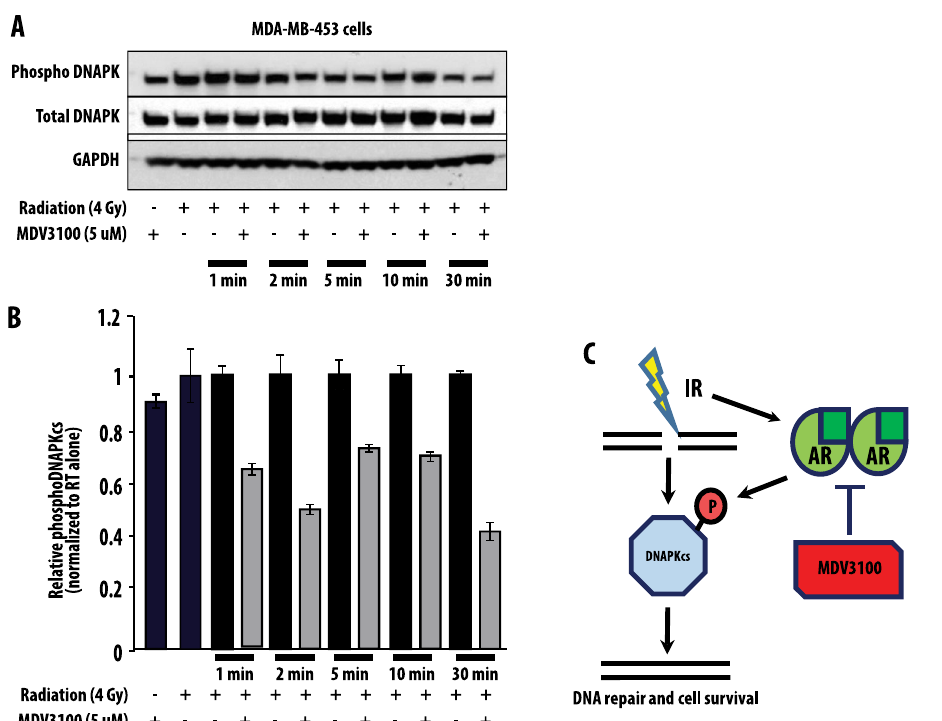
Fig. 6 Total DNAPKcs levels are unchanged by RT treatment, but treatment with MDV3100 decreased phosphorylated DNAPKcs levels after ionizing radiation. Total DNAPKcs and phosphoDNAPKcs levels were measured ± RT and ± MDV3100 treatment at 1, 2, 5, 10, and 30 min ( a ). Quanti fi cation of phosphoDNAPKcs changes ± MDV3100 radiation treatment are depicted ( b ). Mechanistically, AR functions to allow for active phosphorylation of DNAPKcs after leading to more ef fi cient resolution of dsDNA breaks induced by ionizing radiation. This activation is impaired by antiandrogen therapy ( c ). Experiments were repeated in triplicate and error bars represent